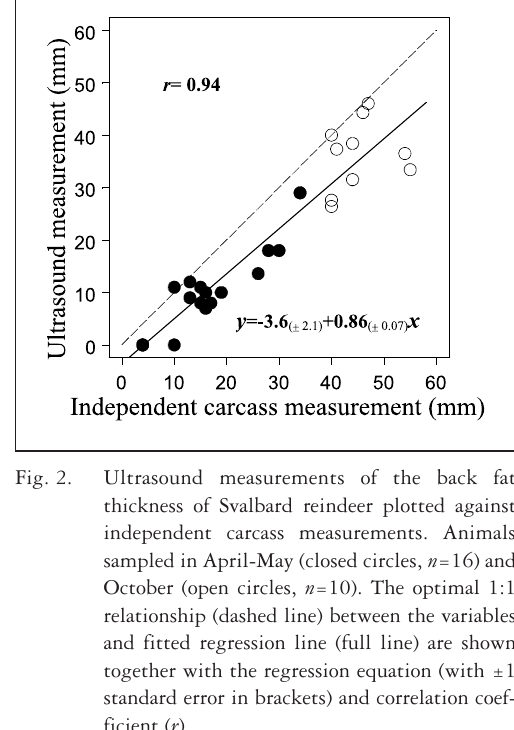
Fig. 2. Ultrasound measurements of the back fat thickness of Svalbard reindeer plotted against independent carcass measurements. Animals sampled in April-May (closed circles, n =16) and October (open circles, n =10). The optimal 1:1 relationship (dashed line) between the variables and fitted regression line (full line) are shown together with the regression equation (with ±1 standard error in brackets) and correlation coef- ficient ( r